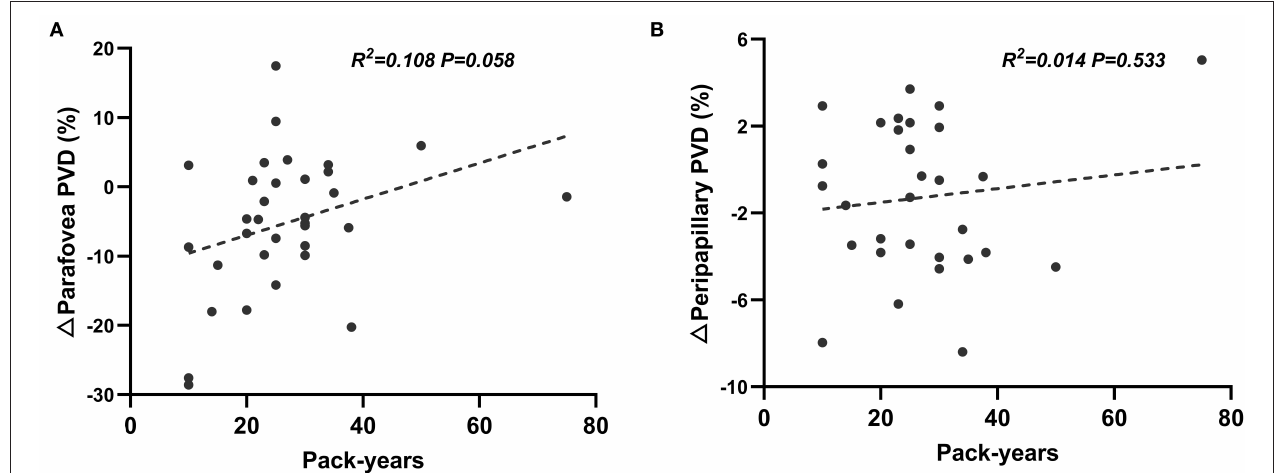
FIGURE 2 | Correlation between pack-years and percentage changes of perfused vessel density induced by Valsalva maneuver in parafoveal (A) and peripapillary (B) regions.